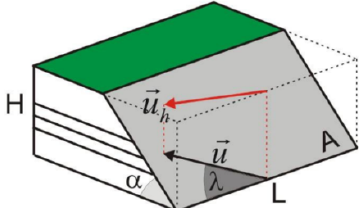
Figure 5. Simple earthquake generation model used to calculate the seismic strain rate. A is the area of the fault, L is the length of the fault, H is the thickness of the seismogenic layer and α is the dip of fault (Matias and Teves-Costa,